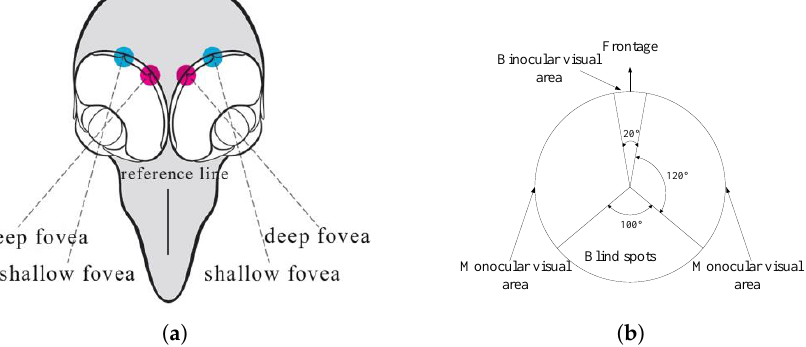
Figure 1. The structure of raptor’s eye. ( a ) Deep fovea and shallow fovea. ( b ) Horizontally-orientated visual